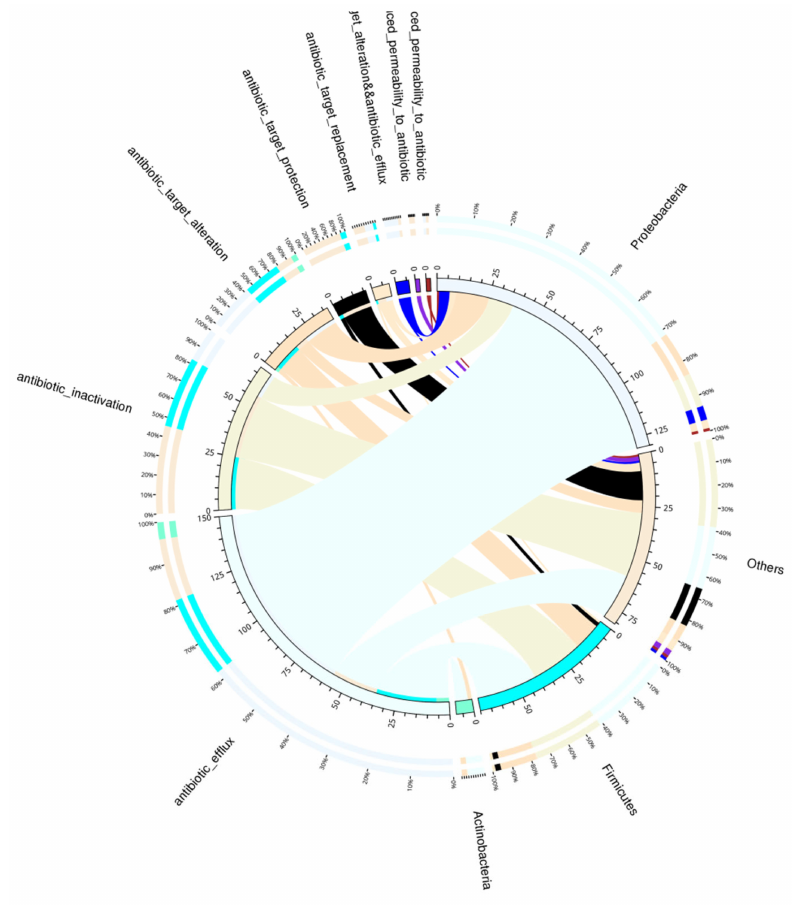
Figure 15. Overview circle of resistance mechanism and species. The circle diagram is divided into two parts: the right side is phylum-level species information, and the left side is resistance-mechanism information. Different colours in the inner circle indicate the resistance mechanisms of different species and resistances, and the scale is the number of genes. The left side is the sum of the number of resistance genes containing such resistance mechanisms in the species, and the right side is the sum of the number of resistance genes contained in the species in different resistance mechanisms. The left side of the outer circle is the relative proportion of resistance genes in each species to the resistance genes of their resistance mechanisms, and the right side of the outer circle is the relative proportion of resistance genes in each resistance mechanism to the resistance genes of their